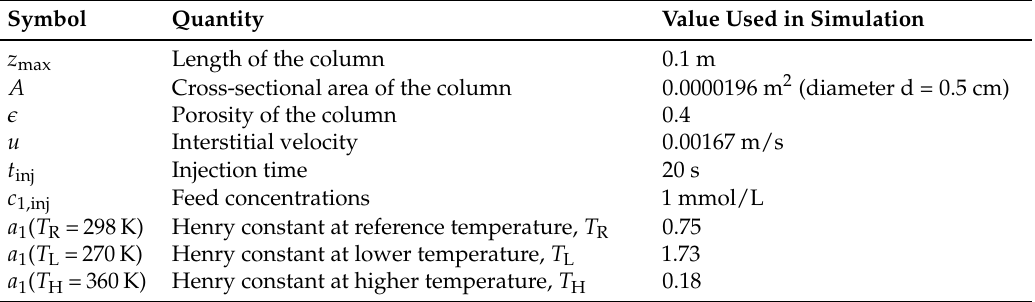
Table 1. Reference parameters used in Section 4.1 (single-component